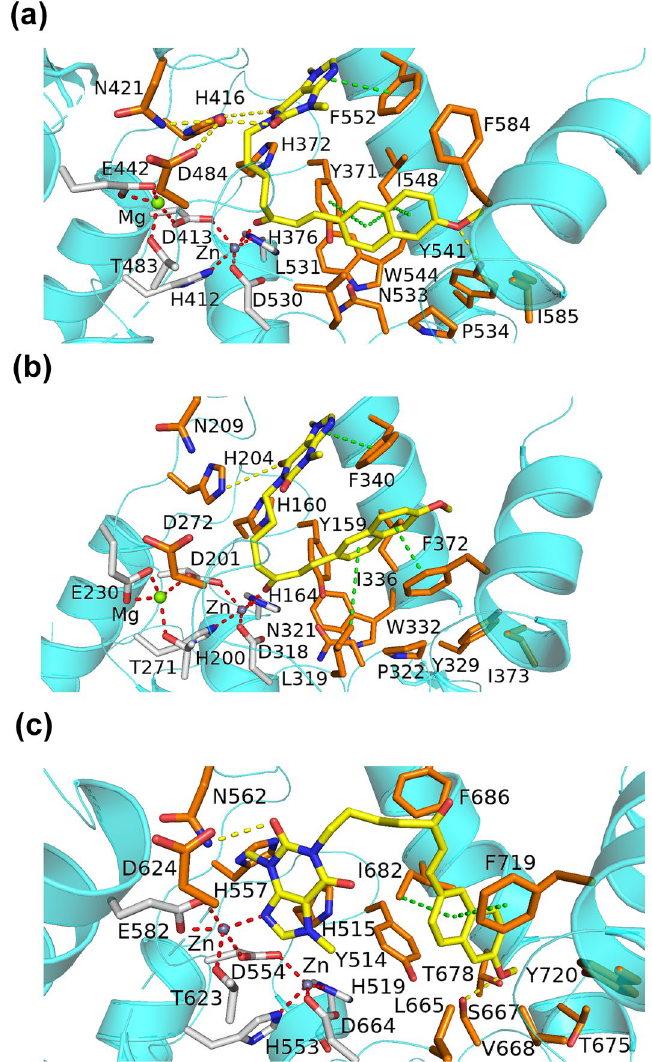
Figure 3. Interaction of PTXm-1 with ( a ) PDE4A ( b ) PDE4D and ( c ) PDE10A. PTXm-1 is shown in yellow sticks, and water, magnesium ion and zinc ion were shown as red, green and grey spheres